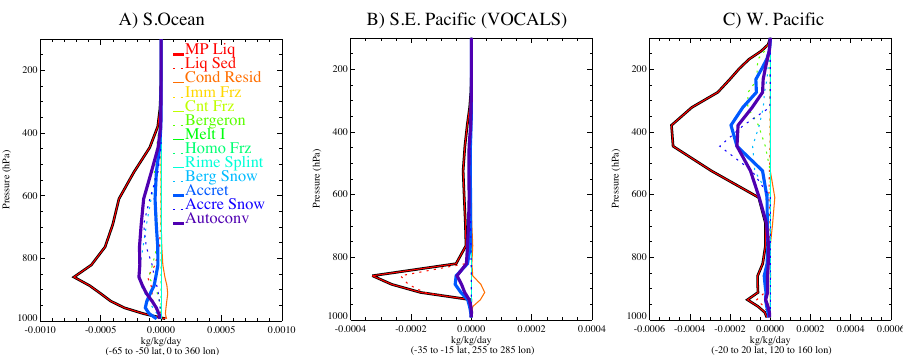
Fig. 1. Profiles of annual average grid mean liquid microphysical process rates (colored solid and dotted lines) in CAM5. (A) Southern Ocean ( − 65 to 50 lat, all longitudes), (B) southeast Pacific ( − 35 to − 15 ◦ S and 255–285 ◦ E) and (C) tropical western Pacific (TWP: 20 ◦ S to 20 ◦ N and 120–160 ◦ E). Processes are the total microphysical tendency (MP Liq), Sedimentation (Liq Sed) and the residual condensation to remove supersaturation (Cond Sed), immersion freezing (ImmFrz), contact freezing (Cnt Frz), the Bergeron vapor deposition process (Bergeron), melting of ice (Melt I), rime splintering (Rime Splint), homogeneous freezing of cloud drops to ice (Homo Frz), autoconversion (Autoconv), accretion (Accret) and the vapor deposition onto snow (Berg